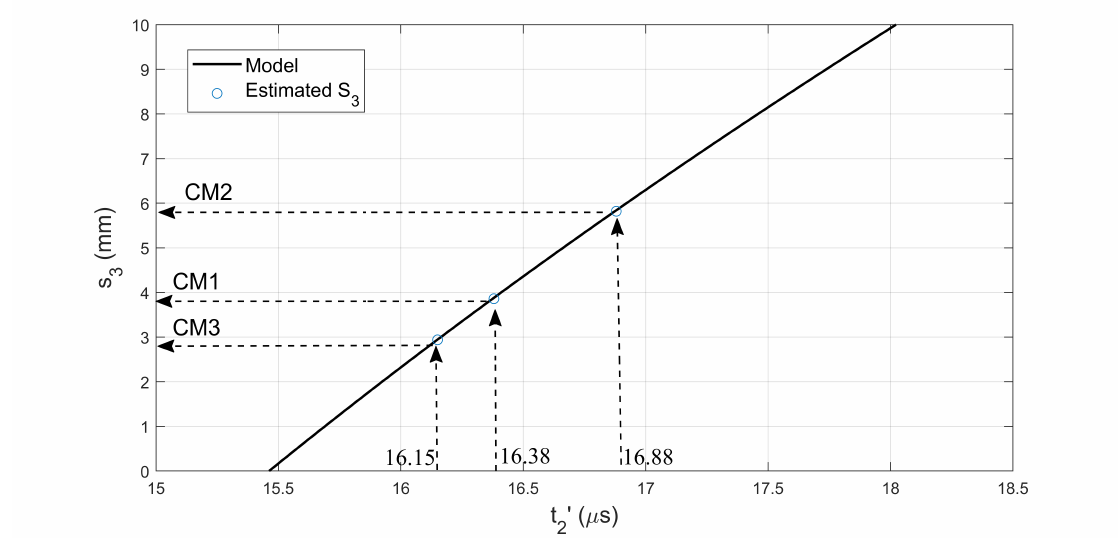
Figure 11. Relationship between s 3 and t (cid:48)